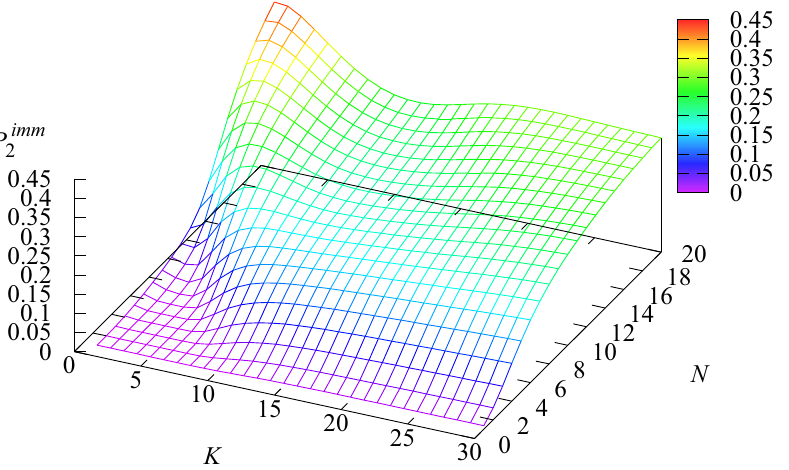
Figure 9. Dependence of the probability P imm System 2 upon arrival on the parameters N and K